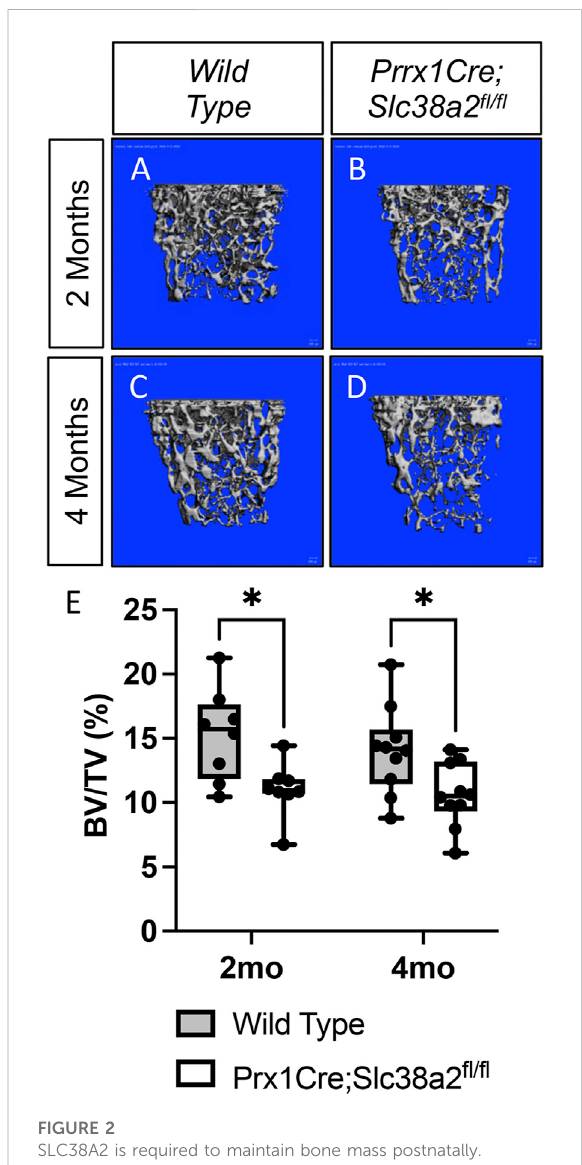
FIGURE 2 SLC38A2 is required to maintain bone mass postnatally. (A – D) Representative µCT images of the trabecular bone in the distalfemurof2- (A – B) or4-month-old (C – D) wildtype(WT) (A,C) or Prrx1Cre;Slc38a2 fl / fl (B,D) male mice. (E) Quanti fi cation of µCTimages.BV/TV — Bonevolume/TissueVolume.* p < 0.005,N= 8miceeachgenotypeat2 months.N=10foreachgenotypeat4-